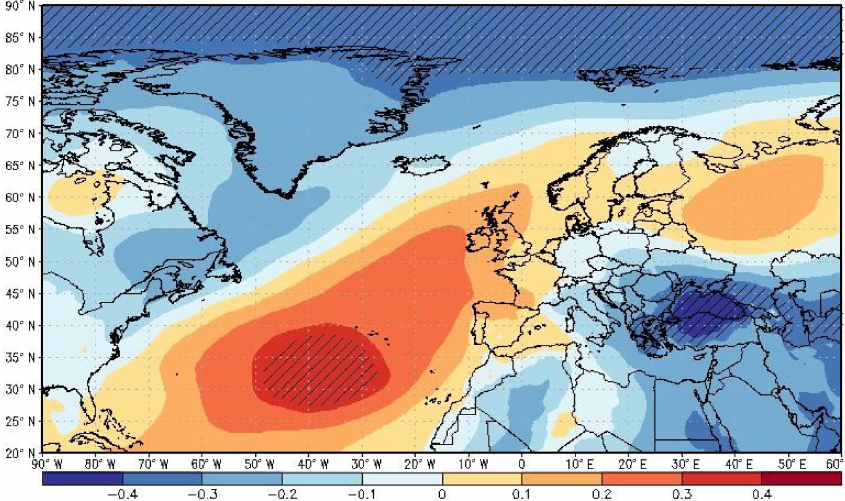
Figure 12. Correlation coefficients between the monthly number of storms in the Prut River basin and monthly means of sea level pressure (SLP) for the active season (May to August) in the period 2003–2017. The SLP data are from the ERA 5 reanalysis (the deterministic dataset). Hatched areas illustrate correlation coefficients statistically significant at confidence levels higher than 99%.